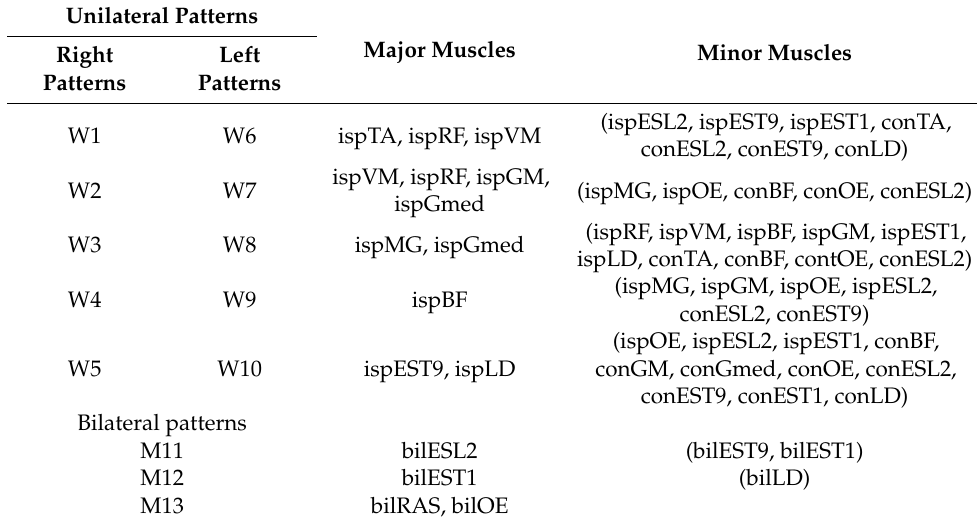
Table 3. Characteristics of muscle synergy clusters of all